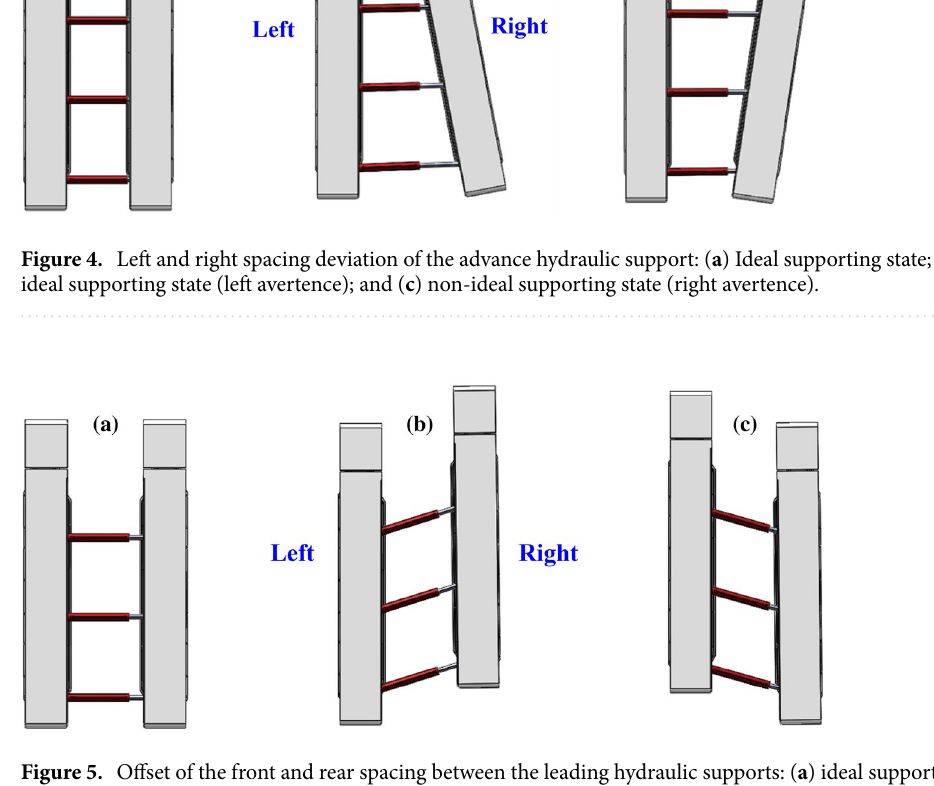
Figure 5. Offset of the front and rear spacing between the leading hydraulic supports: ( a ) ideal supporting state; ( b ) non-ideal supporting state (forward lead); and ( c ) non-ideal supporting state